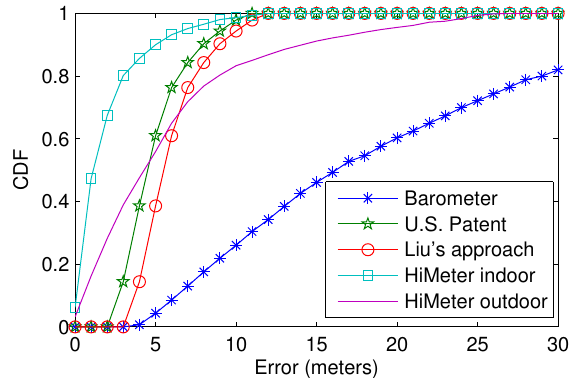
Figure 10. Height accuracy CDF compared to the related works.